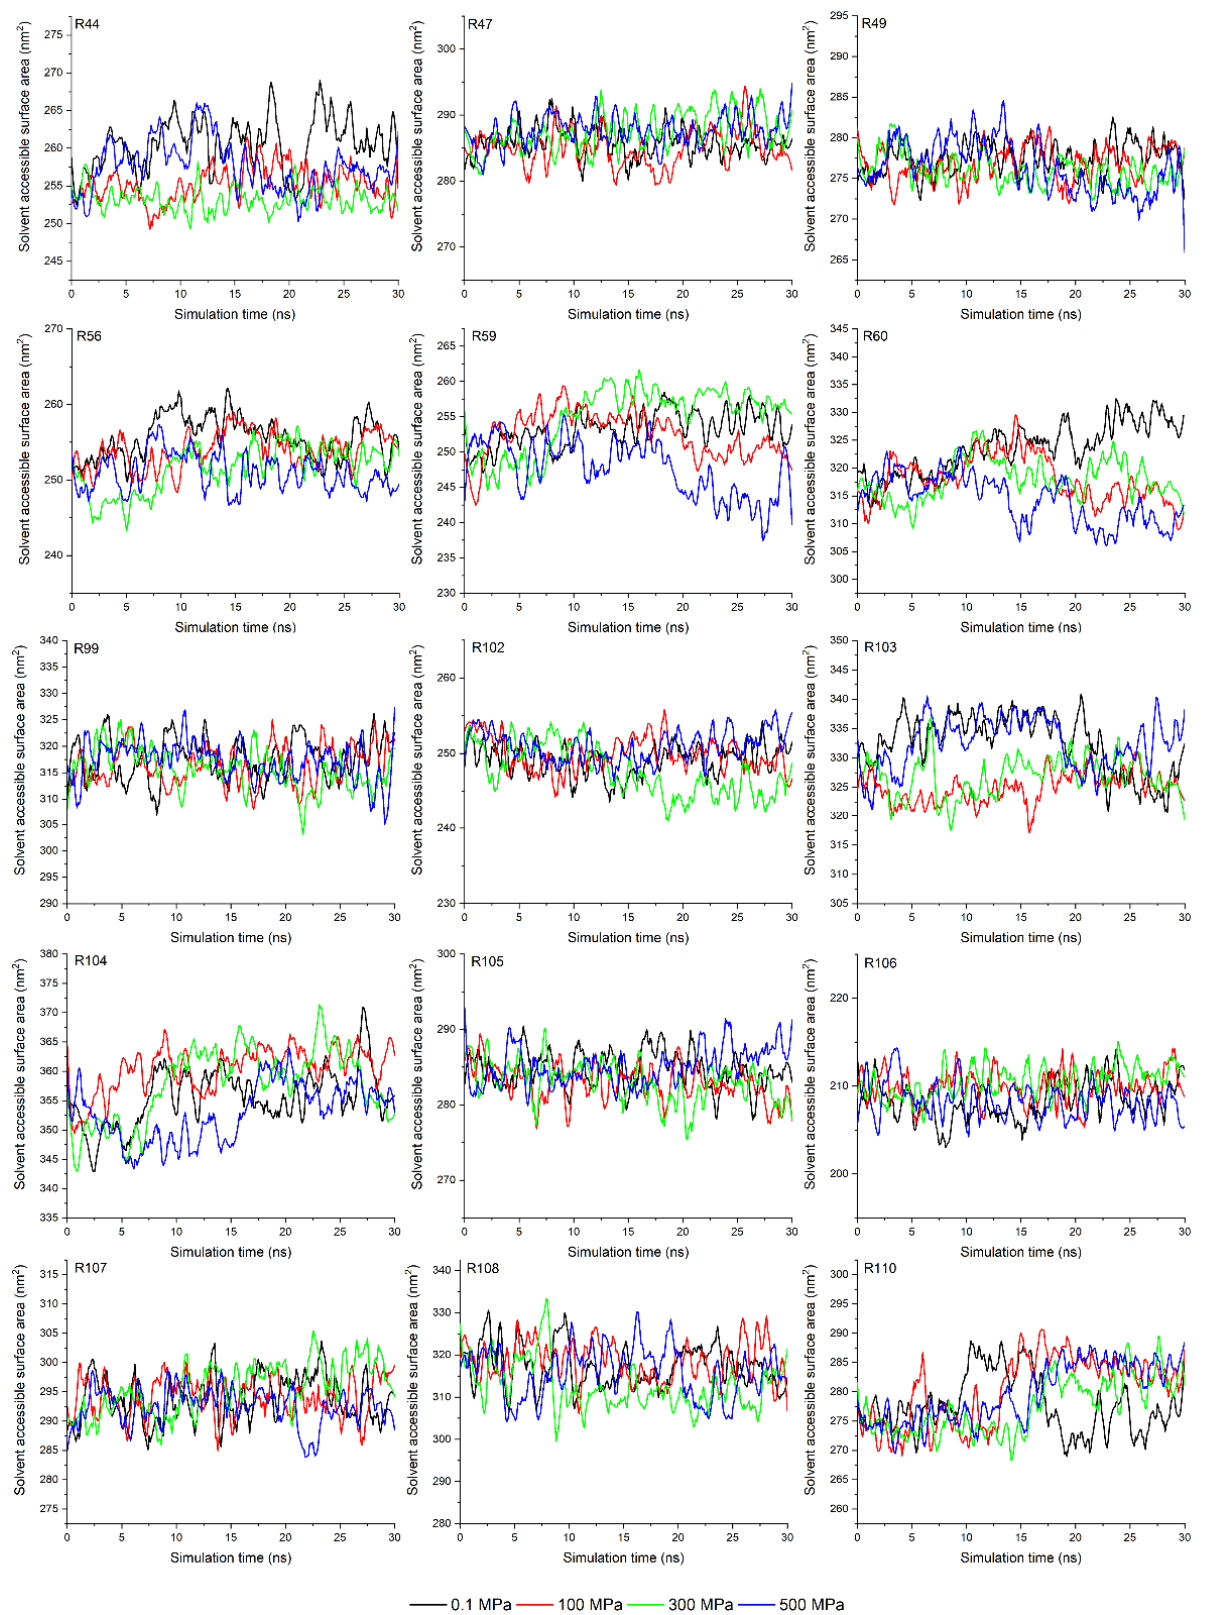
Figure 3. The solvent access area of α-lactalbumin residues in the binding site under different high pressure processing conditions (letter R refers to the residues of α-Lactalbumin).